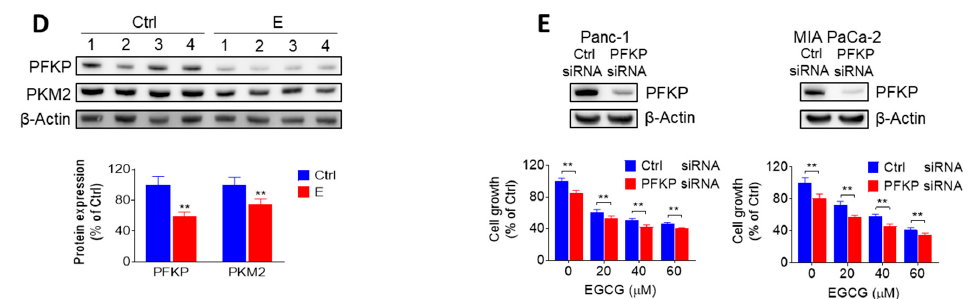
Figure 2. EGCG inhibits glycolysis through suppressing rate-limiting enzyme activity and expression. ( A ) Phosphofructokinase (PFK) and pyruvate kinase (PK) activities were determined in Panc-1 and MIA PaCa-2 cells after treatment with EGCG for 24 h. Results are expressed as a percentage of control. * p < 0.05, ** p < 0.01 vs. control. ( B ) Immunoblots for platelet-type phosphofructokinase (PFKP) and pyruvate kinase M2 (PKM2) in total cell protein extracts from Panc-1 and MIA PaCa-2 cells treated with escalating concentrations of EGCG, as indicated, for 24 h. Loading control: β -Actin. Bands were quantified and results are expressed as a percentage of control. * p < 0.05, ** p < 0.01 vs. control. ( C ) EGCG (40 µ M) inhibited PFKP and PKM2 protein expression in a time-dependent manner in Panc-1 and MIA PaCa-2 cells. Results are expressed as percentage of control and presented as the mean ± SD. * p < 0.05, ** p < 0.01 vs. control. ( D ) Immunoblots of PFKP, PKM2 expression on tumor tissue from control- and EGCG-treated (10mg / kg / d) mice. Results are expressed as a percentage of control. * p < 0.05, ** p < 0.01 vs. control. ( E ) E ff ect of silencing PFKP on EGCG-induced cell growth reduction. Panc-1 and MIA PaCa-2 cells were transfected with either control or PFKP siRNA. After